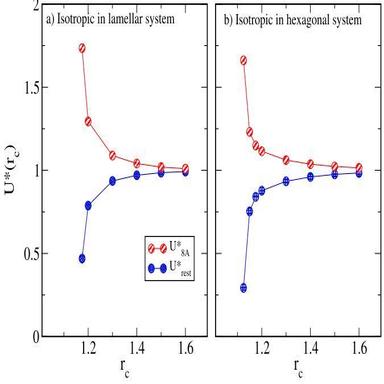
Relative potential energy as a function of cutoff distance ( ) for groups of particles, differentiated by their local ordering. The plot compares the average potential energy per particle in 8A-type clusters (ordered environments) to the average for all particles, and similarly for the rest (less ordered or disordered environments). This relative measure highlights stability differences based on local structural order, with values greater than one indicating enhanced stabilization of clustered particles in